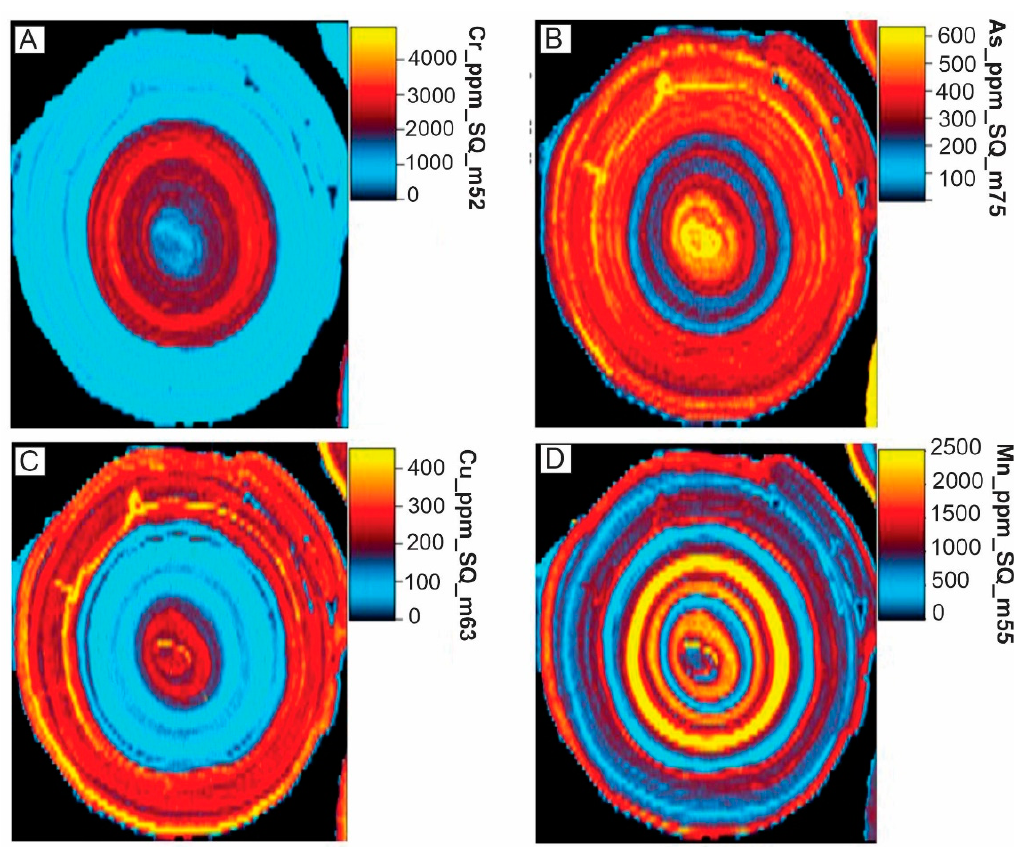
Figure 15. Laser ablation ICP-MS elemental maps showing Cr ( A ), As ( B ), Cu ( C ) and Mn ( D ) for a ferruginous pisolith (approximately 5 mm in diameter, PPS 2) formed in the Perkolilli Shale (PPS).